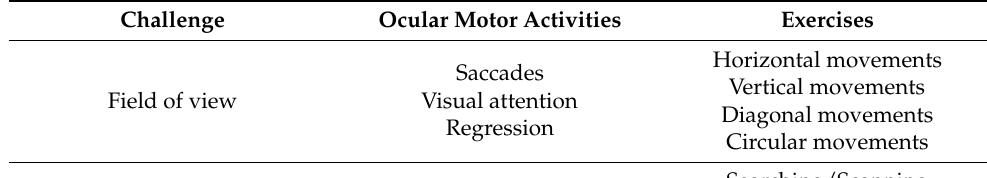
Table 2. Ocular motor activities connected to relevant training exercises.